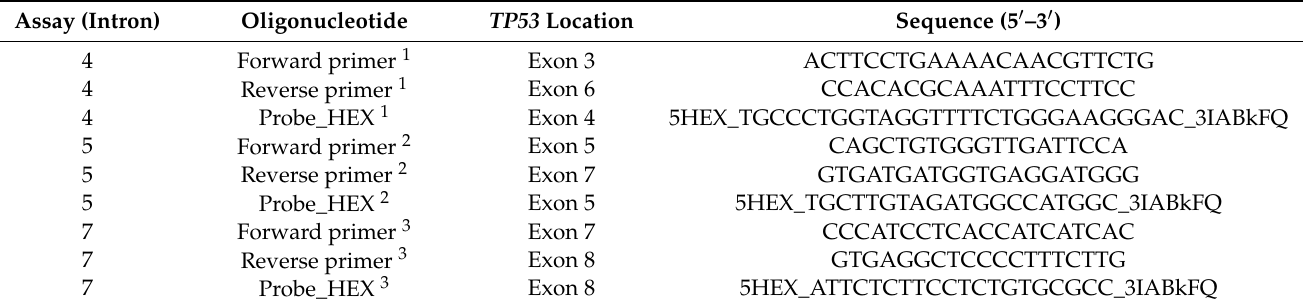
Table 4. Description of primers and probes for TP53 splice mutation long amplicon ddPCR assays.